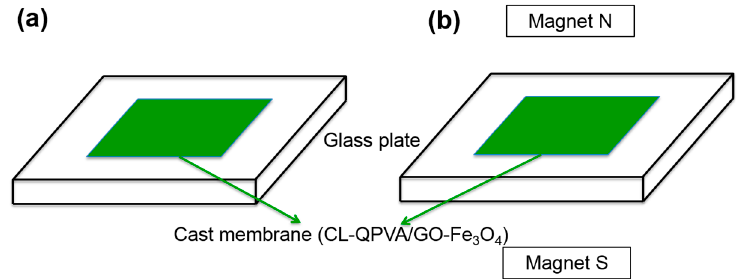
Figure 8. Illustration of CL-QPVA/GO-Fe 3 O 4 nanocomposite membranes ( a ) prepared without the magnetic field; and ( b ) prepared with the magnetic field. The magnets are placed above and below the cast film until the membrane solidified.